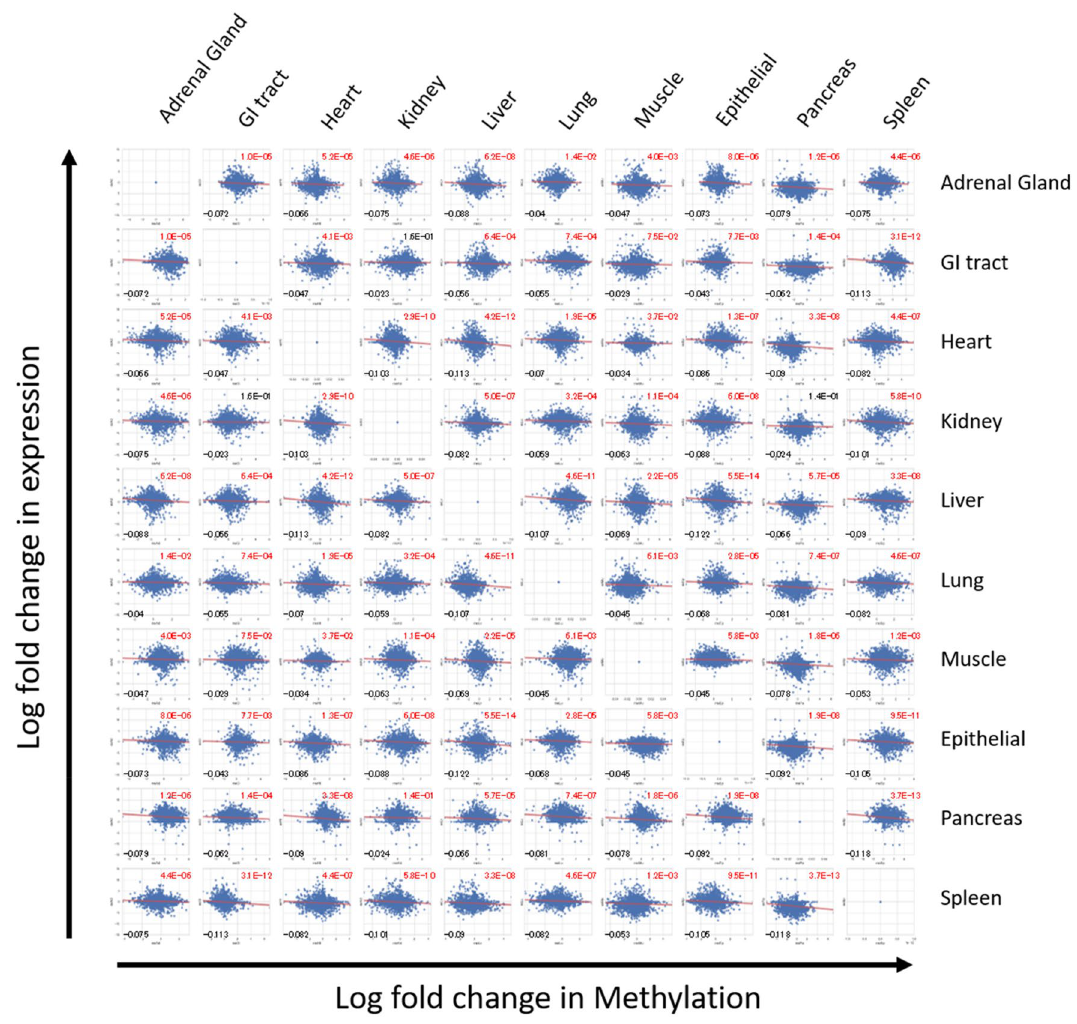
Figure 5. Integration of methylation and expression data. Starburst plot of the 3783 CpG sites that were located at promoter region of transcripts whose gene expression data were available depicted by seaborn (https:// doi. org/ 10. 5281/ zenodo. 592845). Log fold change in DNA methylation (x-axis) and gene expression (y-axis) are plotted for every comparison between each tissue. When the RPKM for a transcript is less than 0.5, the value was adjusted to 0.5. Log fold change were calculated from the value of tissues shown in a row subtracted by tissues in a column. Pearson’s correlation coefficient and p-values were shown in left lower and right upper of each panel, respectively.